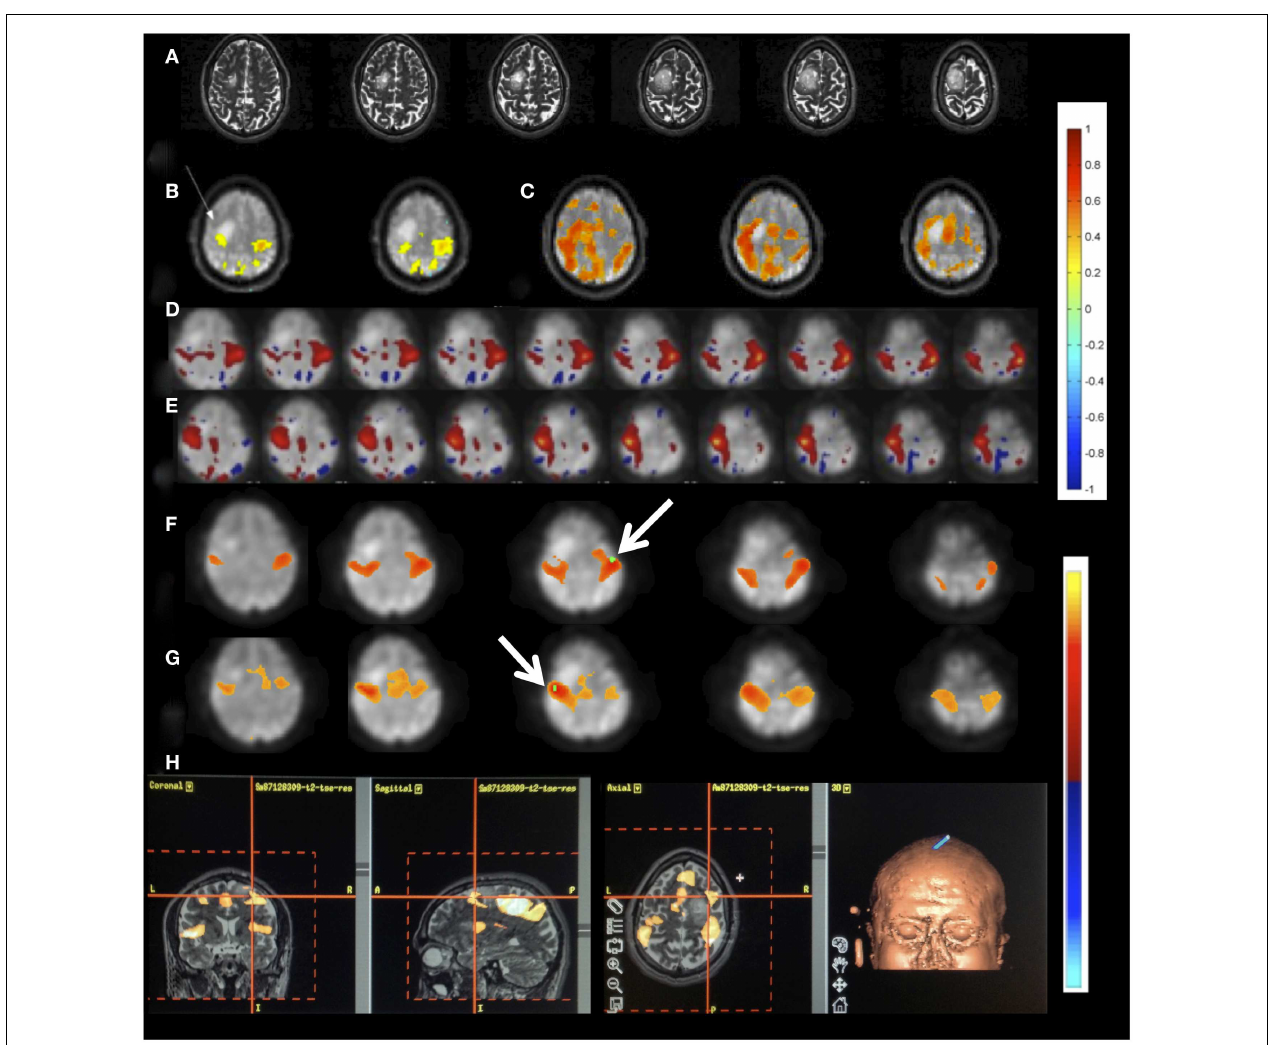
mapping with showing more focal localization ( z max = 12). Seed-based analysis shows focal localization of the sensorimotor RSN consistent with ICA: (F) left motor seed and (G) right motor seed (arrows). (H) Sum of all seed-based resting-state networks in the vicinity of the tumor integrated into presurgical planning. Color scales for task-based correlation analysis and seed-based connectivity (top), and ICA (bottom) are shown on the